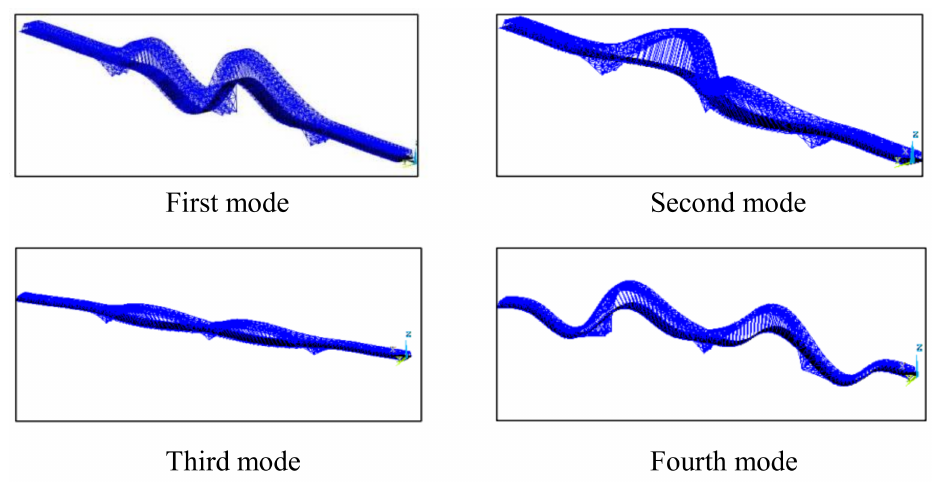
Figure 4. Calculation results of first four dynamical modes. Table 3. Results of dynamic frequencies under the first four modes.